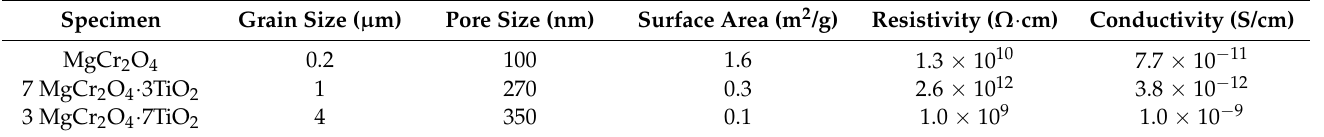
Table 4. Pore structure, resistivity, and conductivity of MgCr 2 O 4 –TiO 2 sintered composites [83].